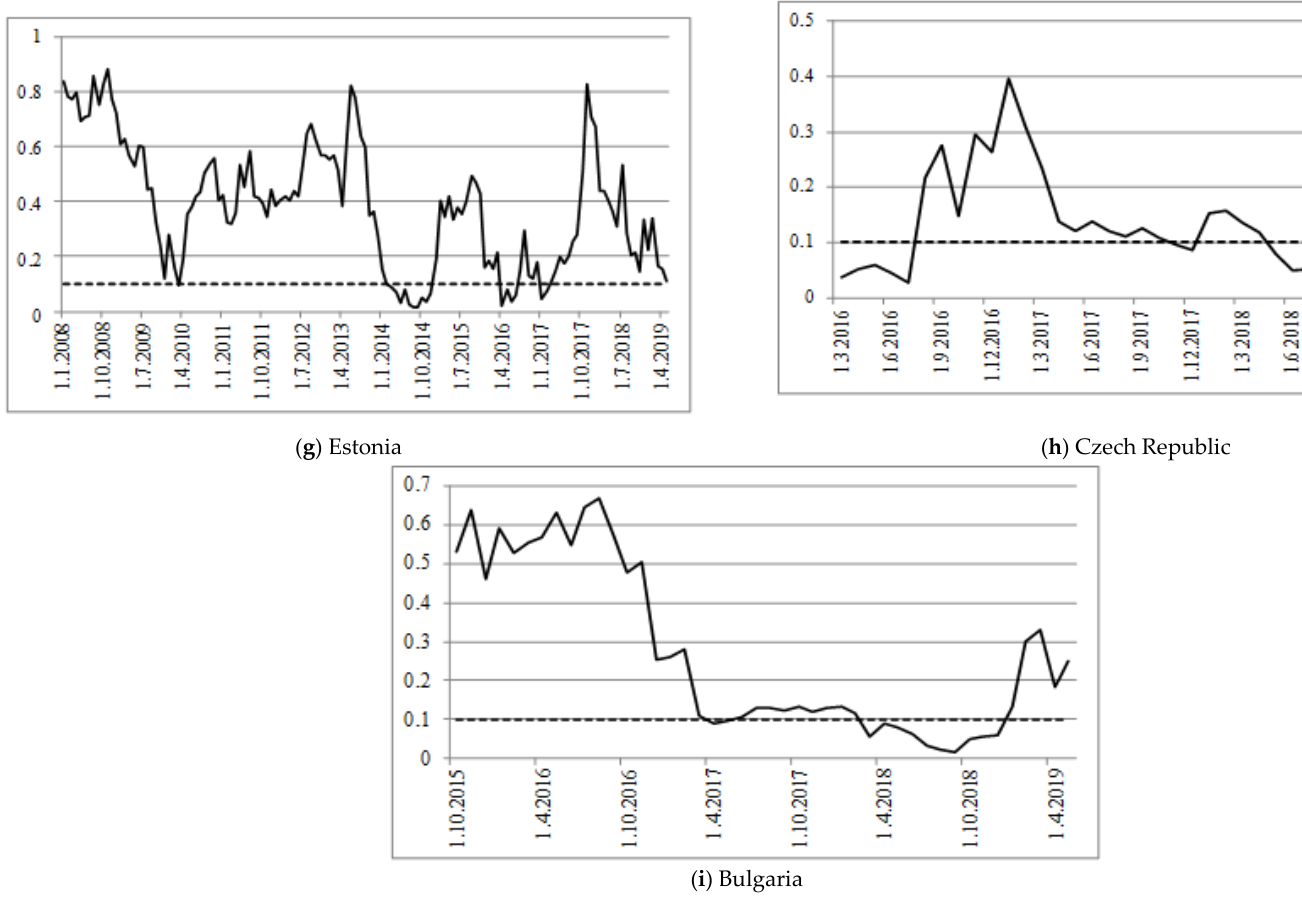
Figure A6. Rolling Granger test p ‐ value for EPU shocks as cause.